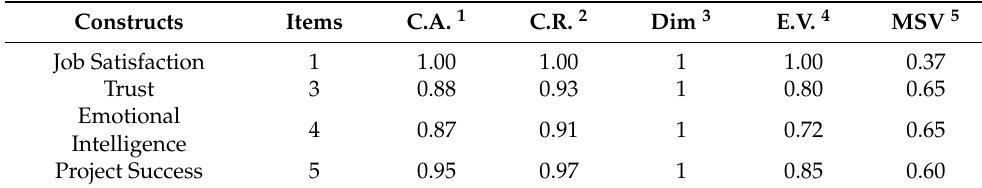
Table 2. Validation of measurement model for 2nd-Order Constructs.